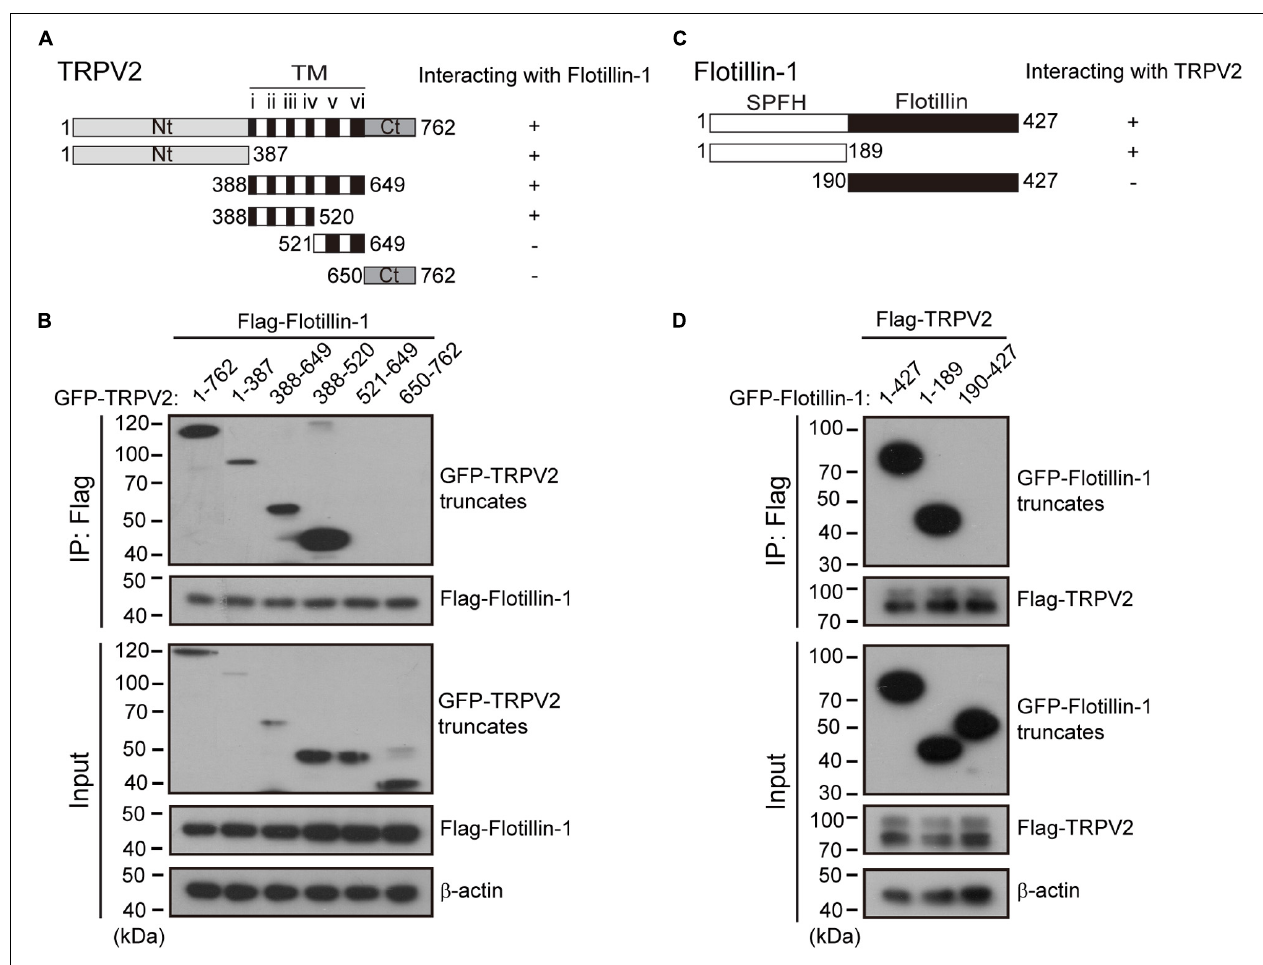
FIGURE 6 | Identification of interaction domains for the association between TRPV2 and flotillin-1. (A) A schematic representation of full-length TRPV2, its mutants that were studied, and their abilities to interact with flotillin-1. The number denotes the position of the amino acid residues. (B) N-terminal region and transmembrane domains 1–4 of TRPV2 are responsible for the interaction between TRPV2 and flotillin-1. HEK 293T cells were transiently transfected with different truncation mutants tagged with GFP and flotillin-1-Flag as indicated. Cell lysates were immunoprecipitated with anti-Flag agarose beads and analyzed by IB using anti-GFP and anti-Flag, respectively. Whole-cell lysates were also used for IB with anti-GFP and anti-Flag for input. (C) Schematic diagram of composition of mutant flotillin-1 including SPFH domain (aa 1–189), and flotillin domain (aa 190–427), and as well as their abilities to interact with TRPV2. (D) HEK 293T cells were transfected with TRPV2-Flag and different mutant flotillin-1 fused with GFP as indicated. Cell lysates were subjected to IP by anti-Flag, followed by IB for anti-GFP and anti-Flag, respectively. Note, molecular weight standards (in KD) are shown on the left. TM, transmembrane. Data are representative of three independent